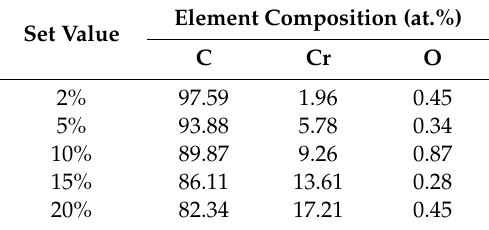
Table 2. Composition of Cr-DLC films.